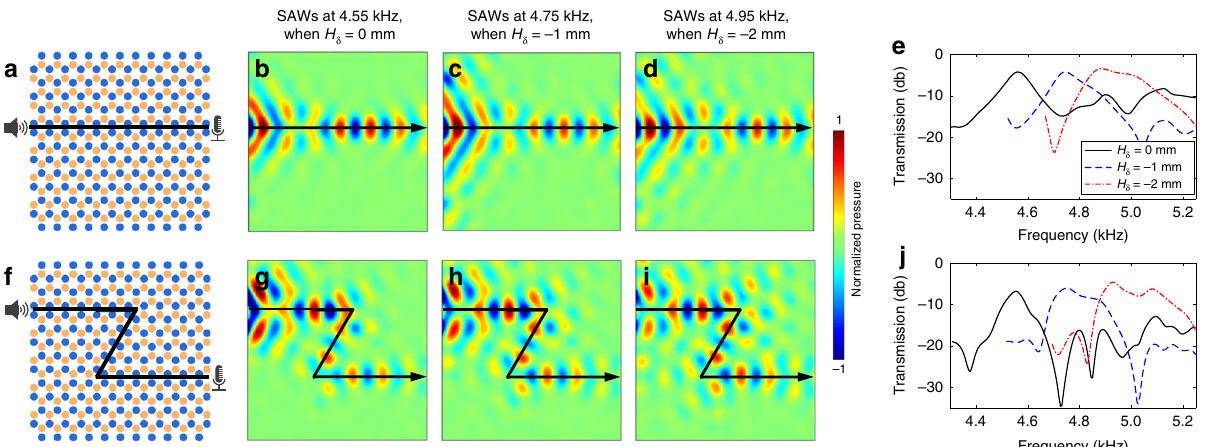
Fig. 4 Experimental results for controlling the edge mode of surface acoustic waves. Con fi gurations of valley phononic crystals (PCs) for transporting surface acoustic waves (SAWs) along a straight and f Z-shaped interfaces. The blue and brown circles represent shallow and deep cavities. Experimental pressure fi elds of SAWs propagating along the b – d straight and g – i Z-shaped paths at 4.55, 4.75, and 4.95 kHz, when the depth changes H δ are 0, − 1 and − 2 mm, respectively. The acquired pressure fi elds con fi rm that the valley Hall edge mode of SAWs can be generated in our valley PCs. Experimental transmission spectra of SAWs along the e straight and j Z-shaped paths. As the depth change H δ decreases, the edge mode ’ s frequency